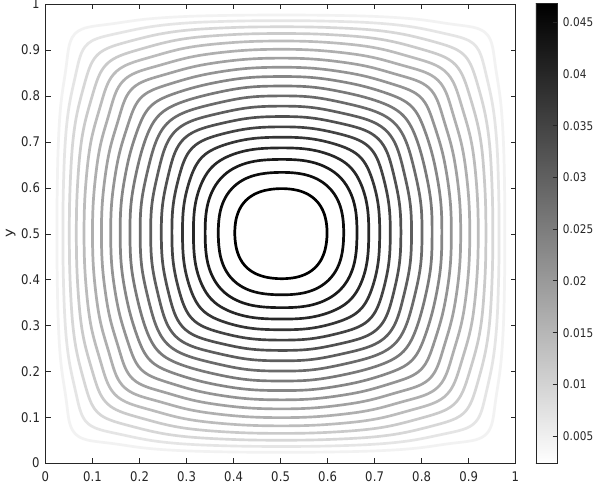
Figure 6. Approximation of the optimal estate. Figure 5: Compliance along the Figure 6: Approximation of the optimal estate